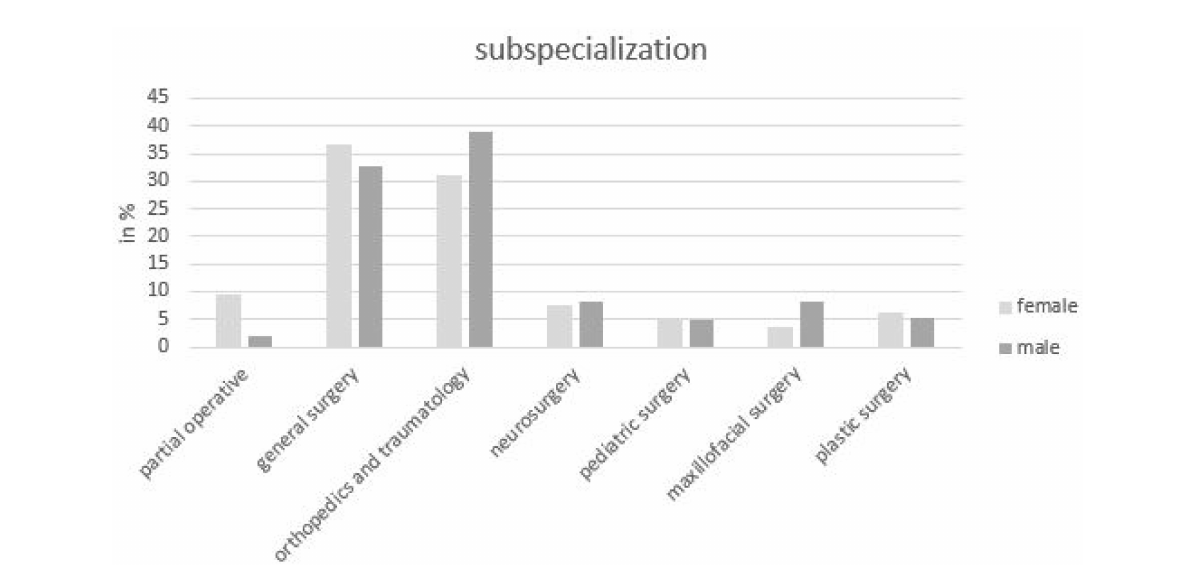
FIGURE1 Epidemiological breakdown of the questionnaire replies. The data were given in percent, subdivided by gender and semester level ( n =